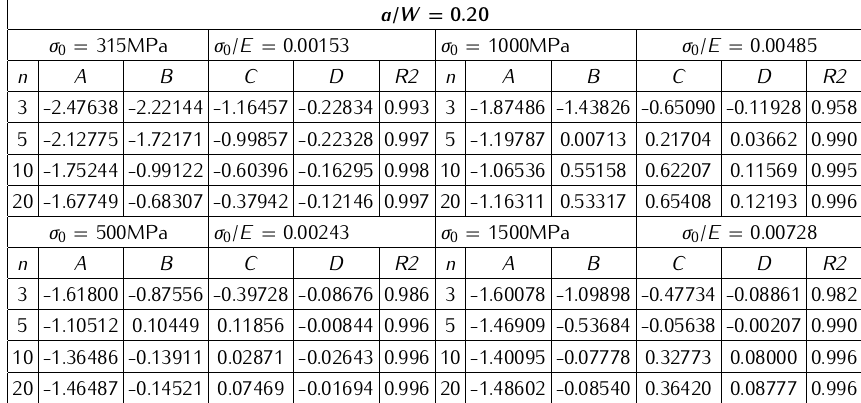
Table 9. The coefficients of equation (13) for SEN(T) specimen with the crack length a / W =0.20.